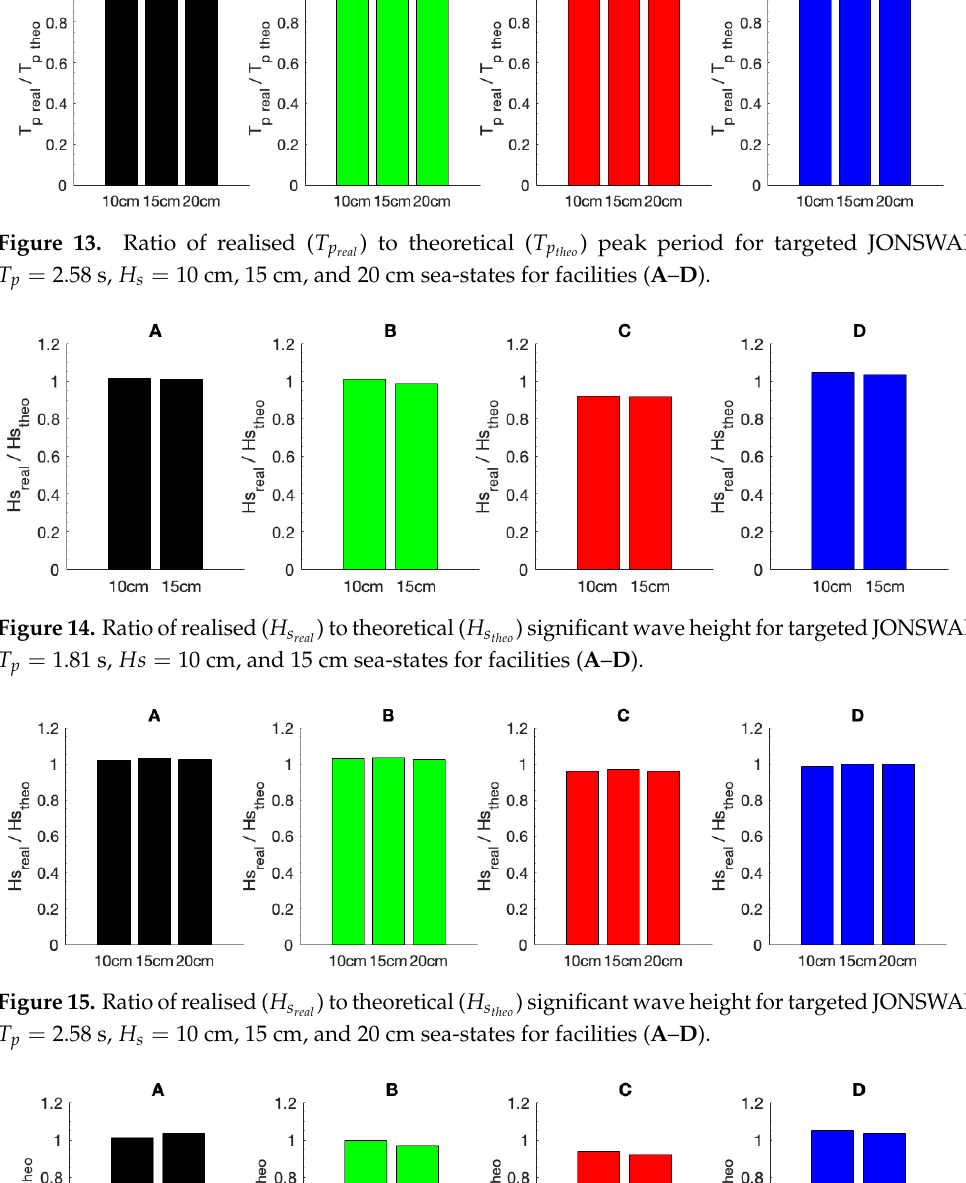
) to theoretical ( H s ) significant wave height for targeted JONSWAP real theo